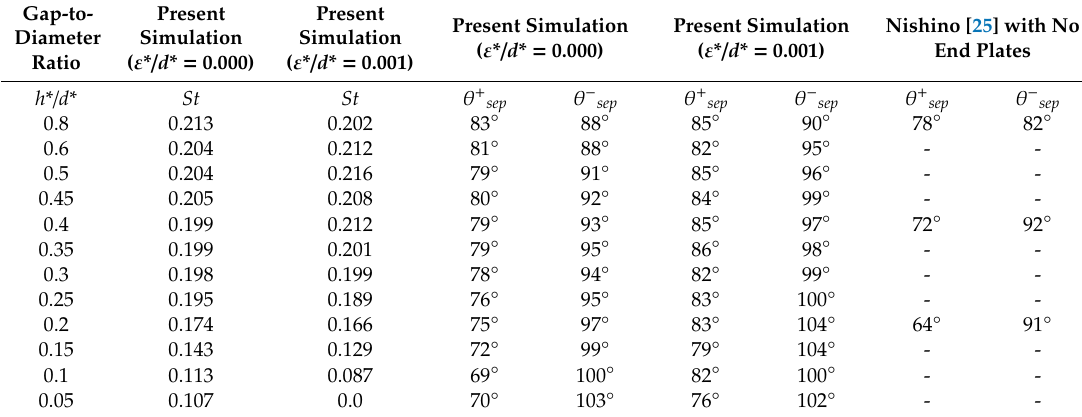
Table 2. Summary of data for the Strouhal number and position of separation for the circular cylinder in the vicinity of a moving wall ( Re = 1.0 × 10 5